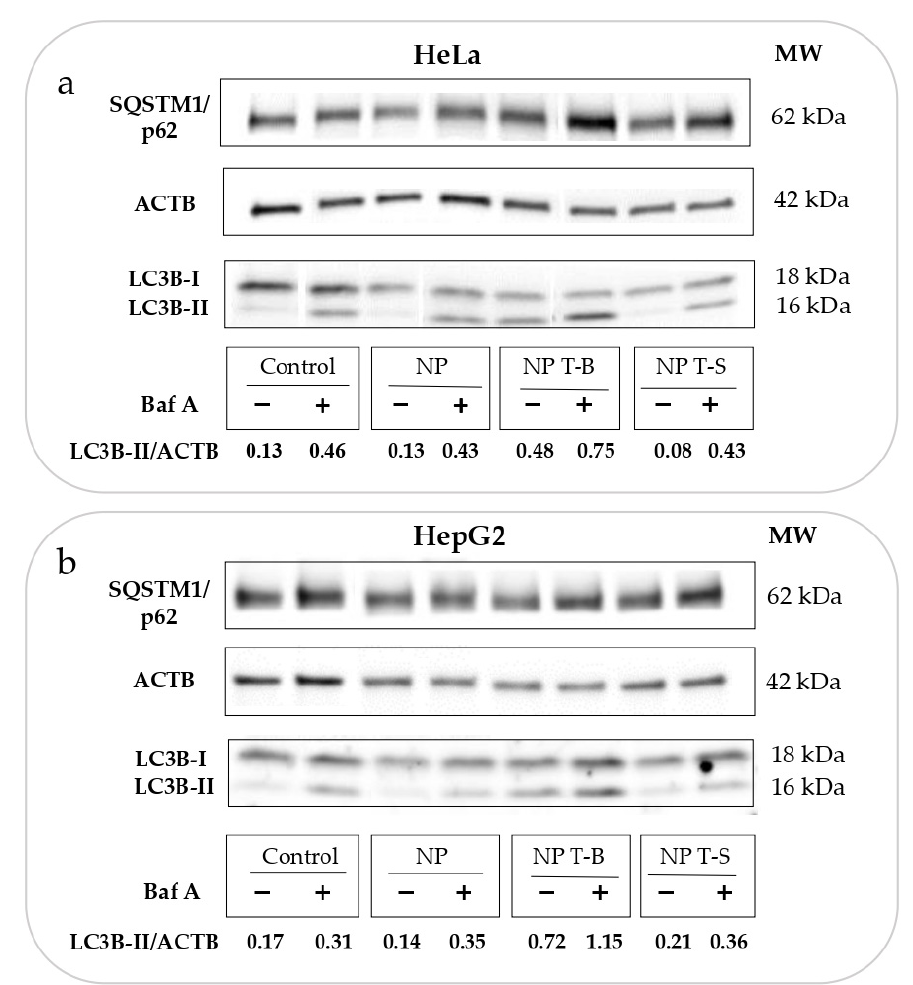
Figure 3. Evaluation of autophagic flux in ( a ) HeLa and ( b ) HepG2 cells treated with particle formulations. Cells were treated with NP T-B (2 µM) or NP T-S (2 µM) or NP for 24 h and bafilomycin A (50 nM) was added at the last 2 h of co-incubation. The LC3B-II/ACTB ratio was quantified in the blots. An increase in LC3B-II/ACTB in the presence of NP T-B and Baf A (NP T-B +) compared to Baf A treatment alone (Control+) denotes that NP T-B are original autophagy inducers. Both blots